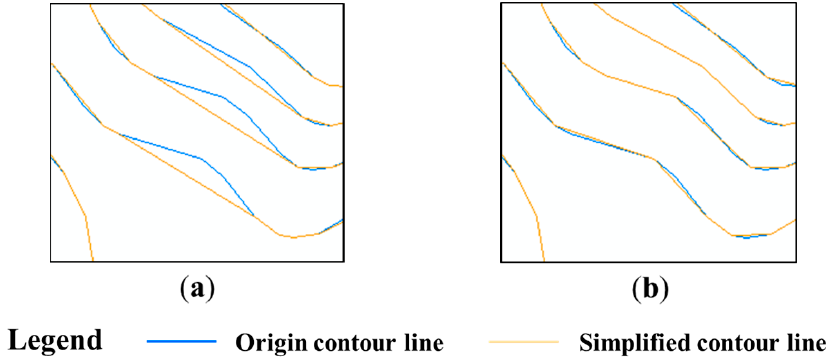
Figure 15. Local simplification results of: ( a ) the method proposed in this study; ( b ) the Douglas– Peucker algorithm.